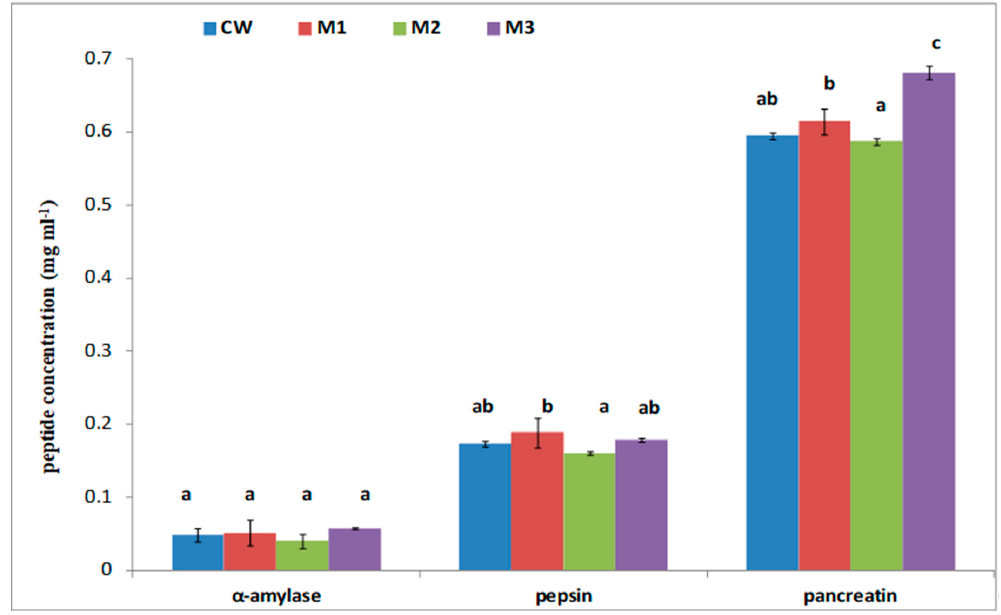
Figure 2. Peptide content in each step of hydrolysis. Di ff erent letters indicate significant di ff